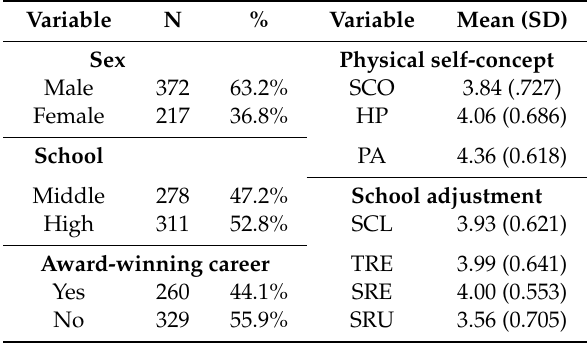
Table 3. Demographic Characteristics and Questionnaire Scores by Variables ( n = 589).